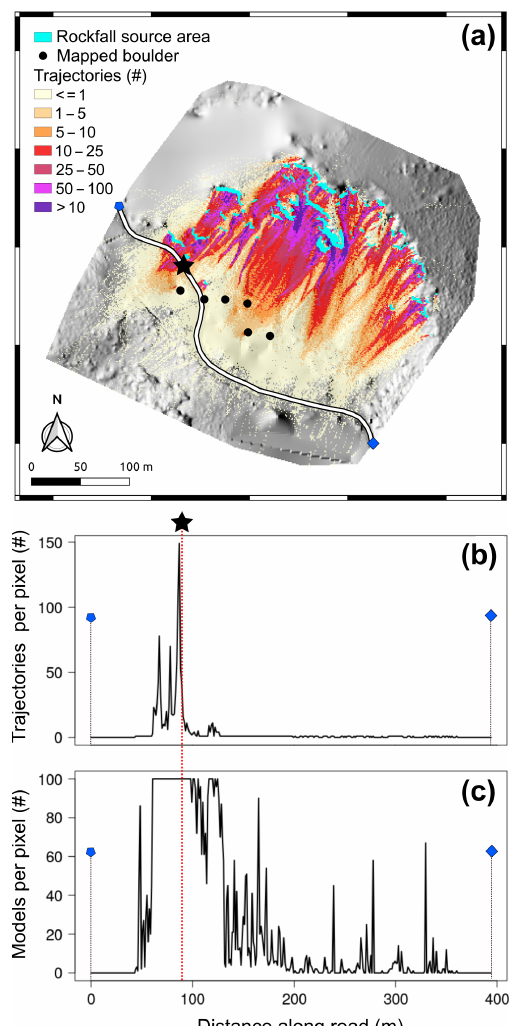
Figure 3. (a) The map shows the mode of count of trajectories of 100 STONE simulations (see text for explanation). Black circles indicate the location of large boulders observed during the field sur- vey at their farthest distance from the source areas (light blue poly- gons). For each pixel along the road track, (b) shows the values of the map (a) and (c) shows the number of STONE simulations in which trajectory count is greater than 0. The star indicates the posi- tion of the impact point along the SP18; blue symbols show the end points of the road